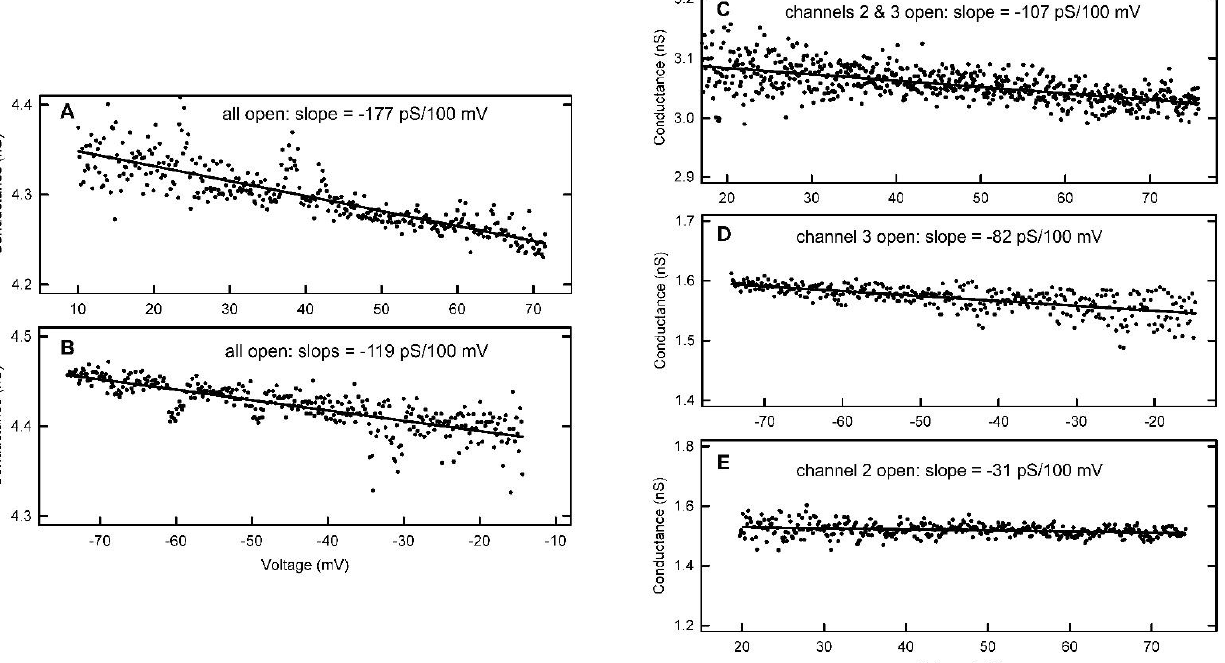
Figure 12. Examples of rectification recorded on single Triplin channels. The triangular voltage waves were run at 30 mHz. Panels ( A , B ) are examples of the voltage dependence of the conductance when all 3 pores are open in a single Triplin. Panels ( C , D and E ) are the same for pores 2 and 3 open, pore 3 only open and pore 2 only open respectively. Table 3. Quantitative measurements of the